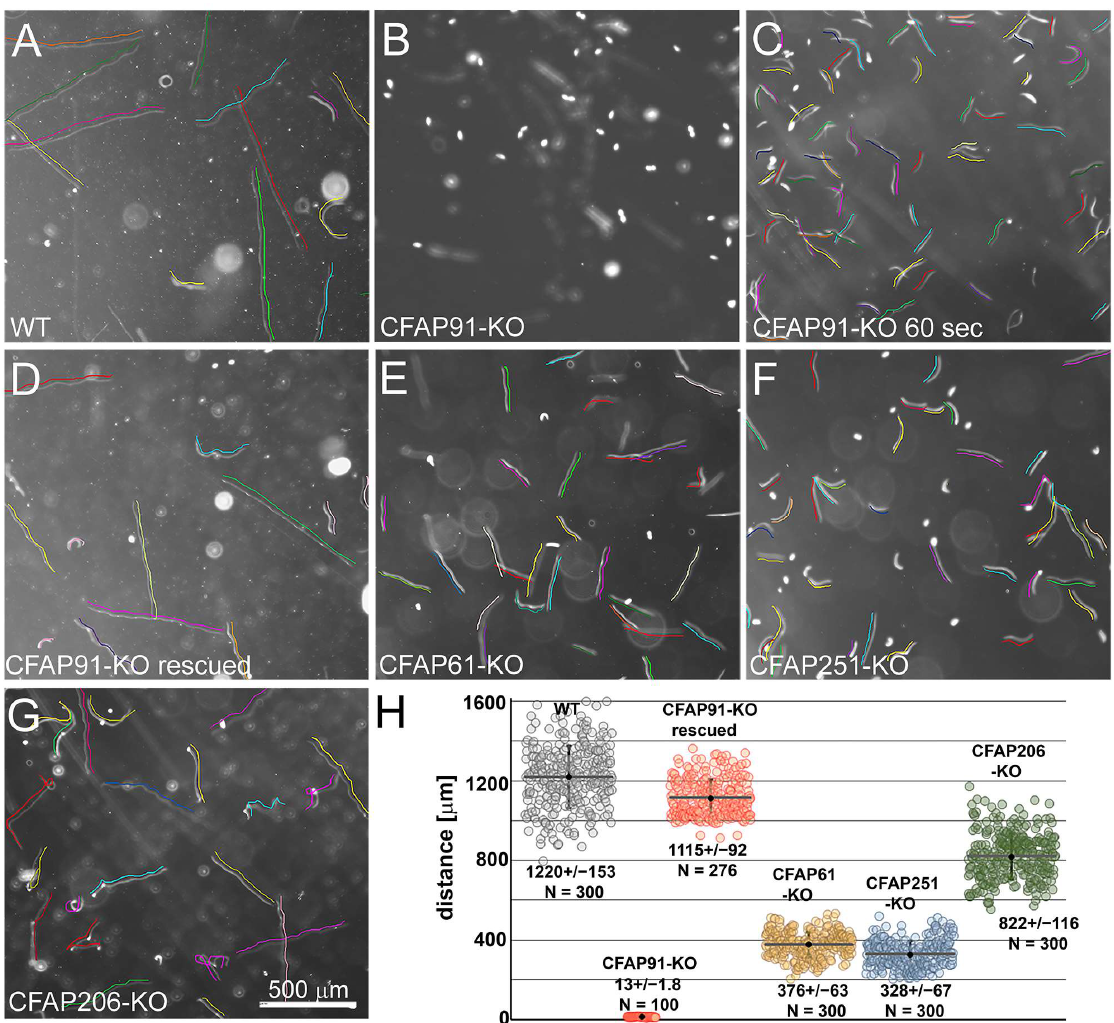
Figure 3. Knockout of genes encoding radial spoke base or radial spoke docking proteins affect Tetrahymena swimming to a different extent. ( A – G ) Swimming paths of wild-type ( A ) and mutant cells: CFAP91-KO ( B , C ), CFAP91-KO rescued ( D ), CFAP61-KO ( E ), CFAP251-KO ( F ), and CFAP206 ( G ). All swimming paths were recorded for 3 s (except for ( C ) where cells were recorded for 60 s) at RT. Cells’ trajectories are indicated by parallel color lines. Bar = 500 μm. ( H ) Graph showing the comparison of the distances traveled by the wild type (WT) and analyzed mutants for 3 s. Error bars represent standard deviation. The traveled distance with standard deviation and number of measured trajectories (N) are indicated. Calculated p -value ( t -test): WT/91-KO 5.67 × 10 −272 , WT/91-res 8.6772 × 10 −264 , WT/61 8.6772 × 10 −264 , WT/251 1.265 × 10 −277 , and WT/206 4.9965 × 10 −147 . The detailed analyses of CFAP91-KO mutant ciliary behavior using a high-speed camera showed that cilia beating was significantly altered (Figure 4). In wild-type cells, cilia beat with the metachrony. During the power stroke, a cilium is stiff and its tip marks almost a semicircle (from the anterior to the posterior cell end) in the plane perpendicular to the cell surface. During the recovery stroke, a cilium bends and the position of the bend shifts from the cilium base to the tip as the cilium returns in the plane parallel to the cell surface to its initial position (Figure 4A,B, Supplementary Movie